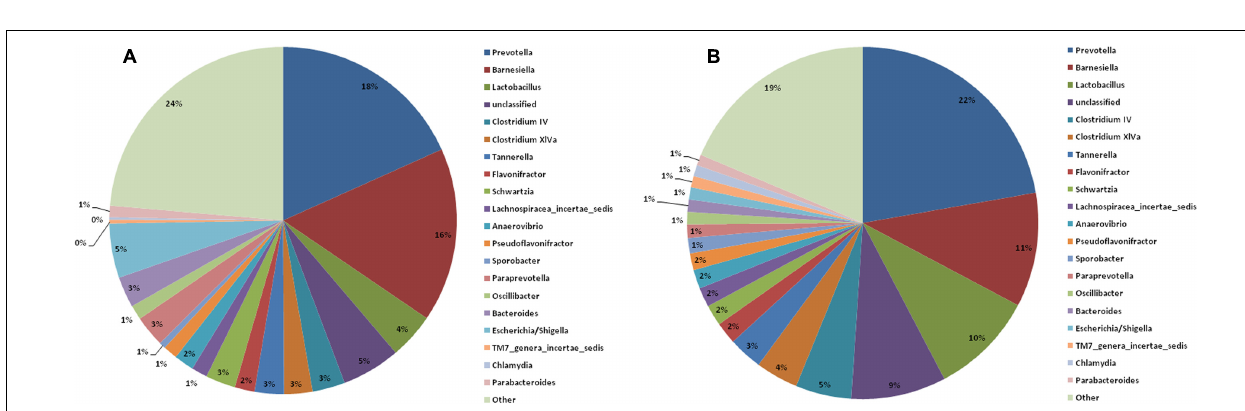
Frontiers in Microbiology |